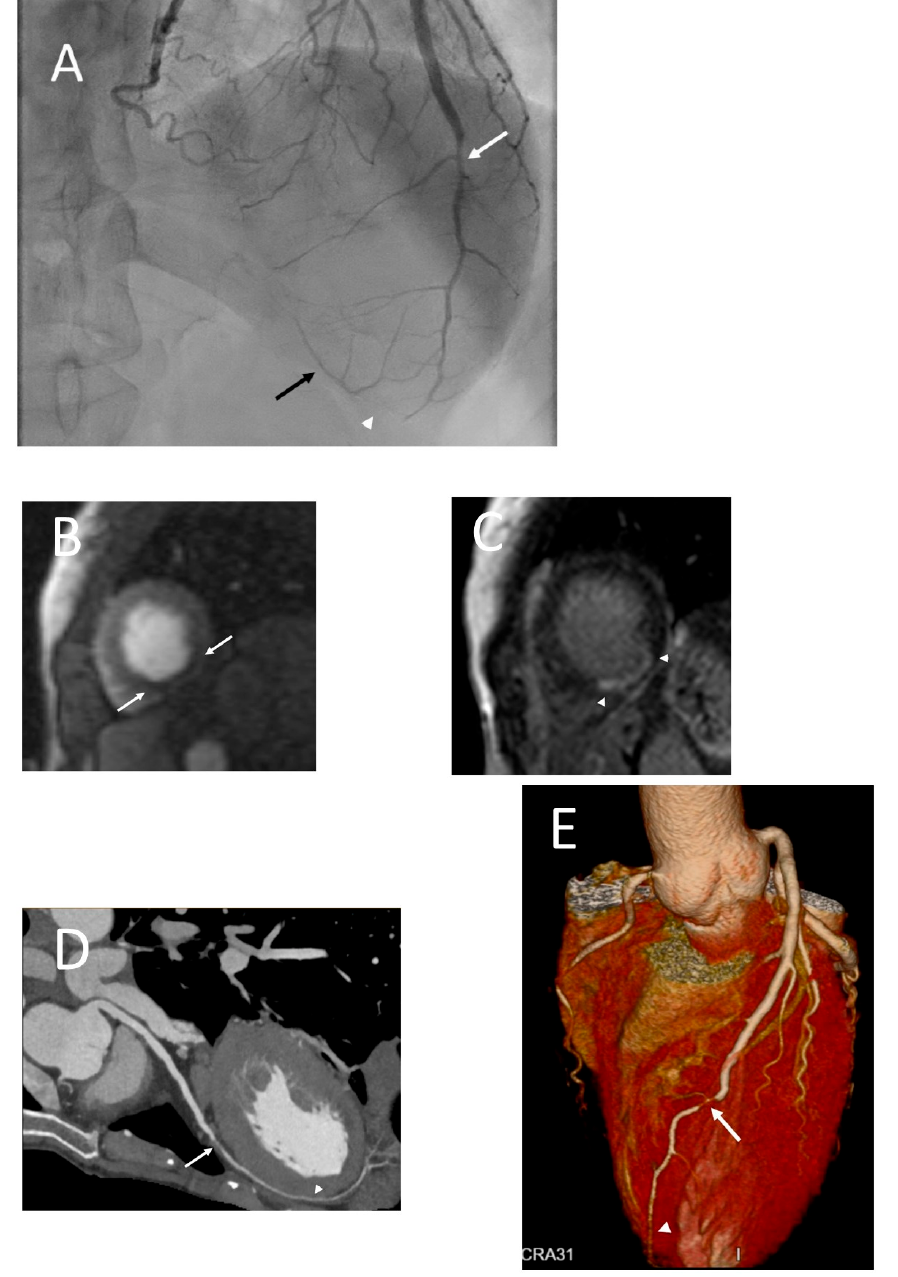
Figure 5. Series shows catheter angiogram ( A ) which shows moderate stenosis of the mid left anterior descending coronary artery (LAD; white arrow) and occlusion of the distal LAD (white arrowhead) with distal collaterals (black arrow). No other significant stenosis in rest of the coronary arteries (not shown) seen, findings which are consistent with SCAD. Cardiac MR ( B , C ) performed later revealed resting perfusion defect ( B ) in the apical inferior wall (arrow) with corresponding subendocardial (near 75%) late gadolinium enhancement (arrowhead; C ) consistent with an infarct in the distribution of the left anterior descending coronary artery. Three days after discharge and cardiac MR, the patient presented again with band-like c lower chest pain and coronary CT angiogram ( D , E ) was performed. Curved planar reformat ( D ) and volume rendered ( E ) images now revealed focal severe stenosis (white arrows) in the mid LAD with recanalization of the distal segment (arrowhead) compared to the catheter angiogram performed five days prior.